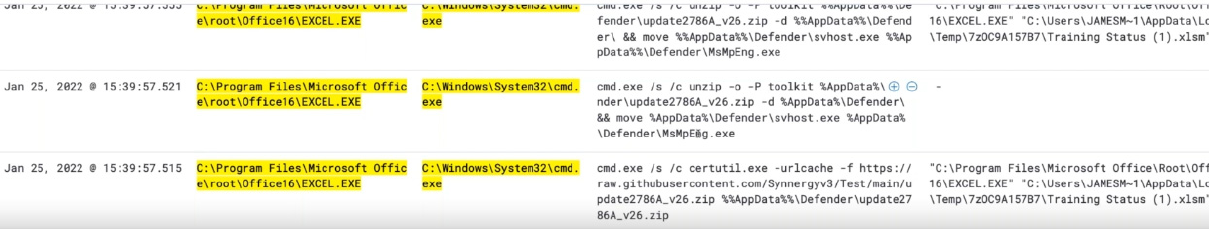
Figure 9. Payload analysis.